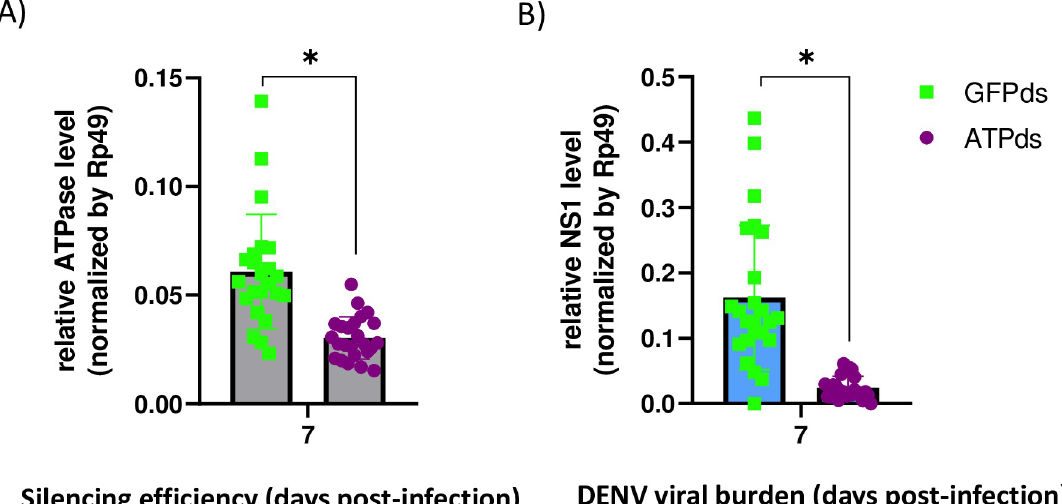
Fig 6. Dissemination analysis of DENV2 in ATPase dsRNA-knockdown mosquitoes. A) ATPase silencing efficacy (grey bars). B) DENV2 viral load recovered from DENV2 infected A . aegypti mosquitoes (blue bars). ATPase and DENV2 RNA levels were analyzed by qRT-PCR and normalized to the levels of Rp49. Green squares correspond to GFP silenced mosquitoes (control) and purple circles correspond with ATPase silenced mosquitoes. Results are representative of two independent experiments. Asterisks represent significant difference between samples, calculated by Mann-Whitney non-parametric test (p �